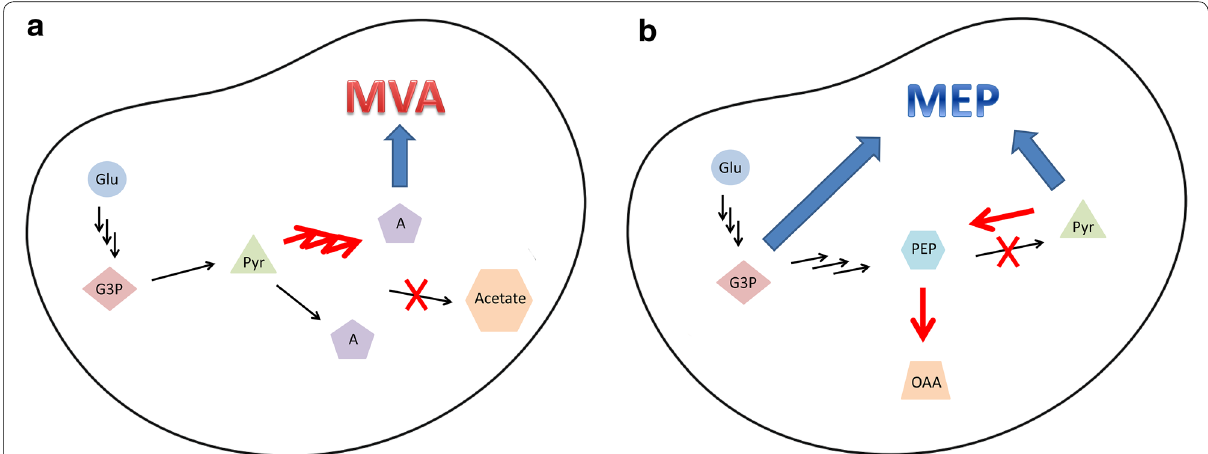
Fig. 2 Rewiring the central metabolic pathway by a increasing the supply of acetyl-CoA and b balancing the supply of glyceraldehyde 3-phosphate and pyruvate. The bold red arrows indicate overexpression of corresponding enzymes (pathways) and red forks indicate disruption of corresponding